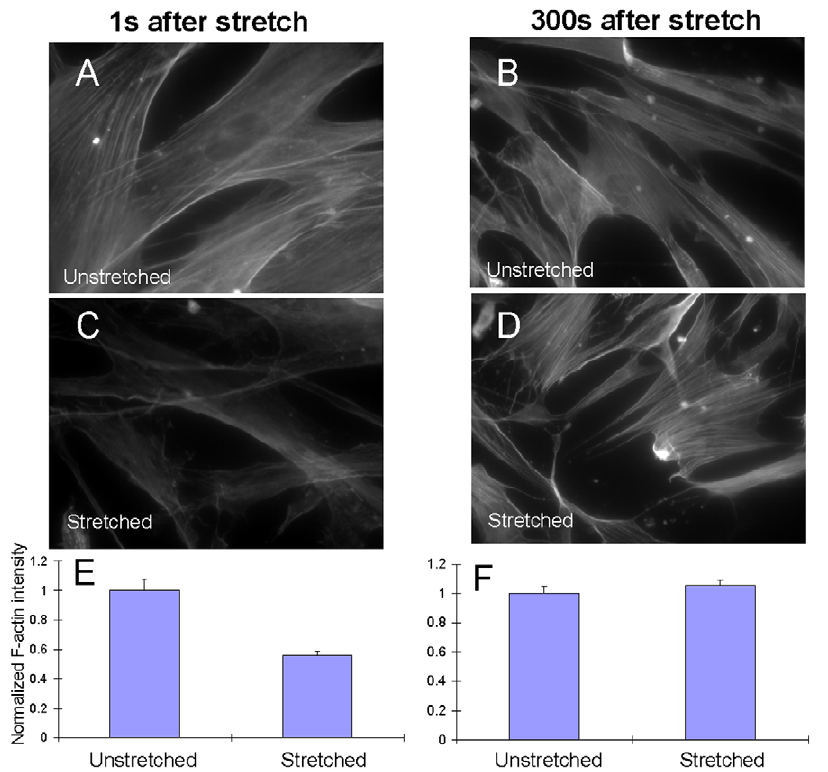
Figure 3. A major component of fluidization is F-actin disassembly: staining results. Within each well, F-actin levels in stretched HBSM cells (inside the indenter footprint) were compared to those in unstretched cells (outside the indenter footprint). (A),(C), F-actin filaments rapidly dissociated immediately after stretch. (B),(D), the F-actin levels recovered to baseline 300 seconds after stretch. (E),(F), from those images, we quantified intensities. Within each dish, we normalized average F-actin intensities in stretched cells to those in unstretched cells (6 dishes in total for each condition) and pooled the values together. Average F-actin intensity in stretched cells was 50% lower than that in unstretched cells immediately after stretch (Figure 3E; p , 0.05, two-tailed unpaired Student’s t-test), but recovered to prestretched values 300s after stretch (Figure 3F). Data are reported as mean + SE (n=14–29 cells).